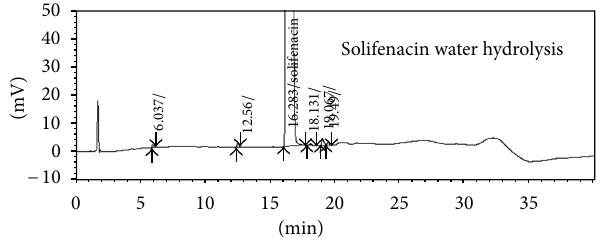
H O ) stressed solution. 2 2 %